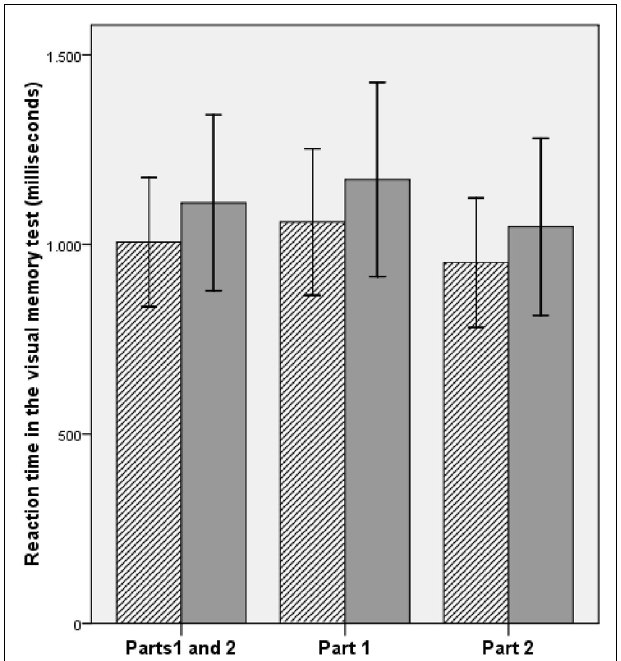
FIGURE 2 | Reaction time in the visual memory test (parts 1 and 2, part 1 and part 2) in musicians (crosshatched) and non-musicians (gray). Musicians performed better than non-musicians in all three situations ( p < 0.05). Error bars represent ± 1 SD.